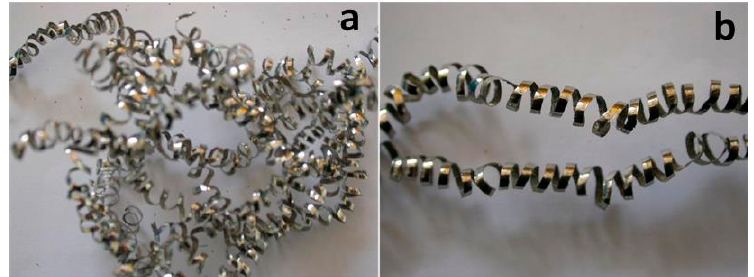
Figure 12. Optical images of tool wear and failure of Al 2 O 3 /TiAlN-coated insert (( a ) under dry cutting; ( b ) under MQL; cutting time t = 12 min).